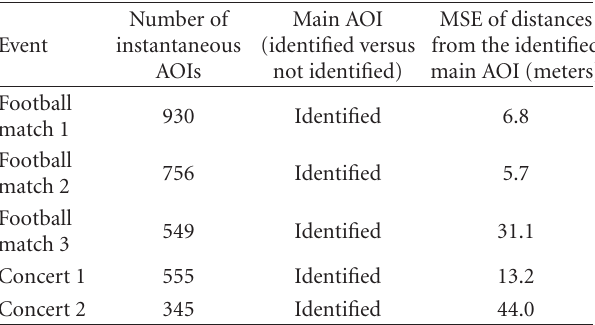
Table 5: Experimental results on area of interest identification (AOI) applied on Dataset 2. MSE stands for Mean Square